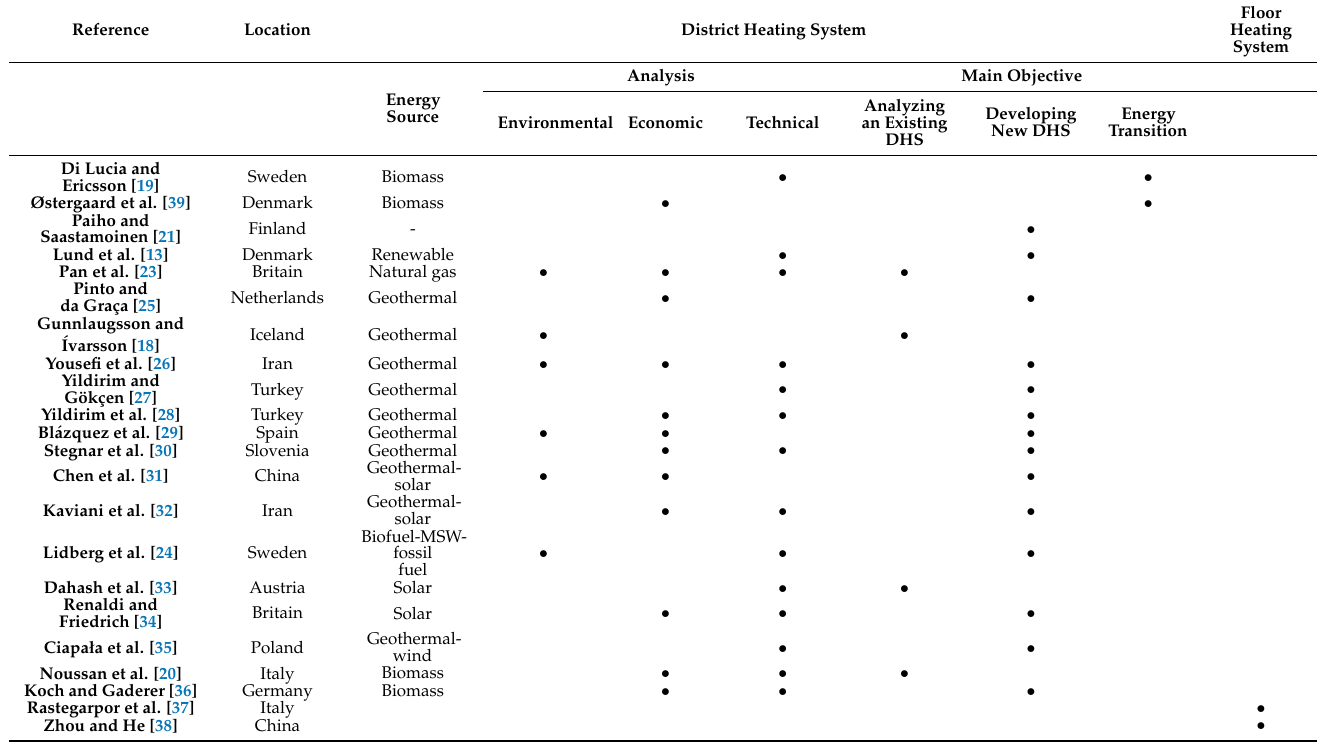
Table 2. Summary of investigated studies in the literature review ( • =